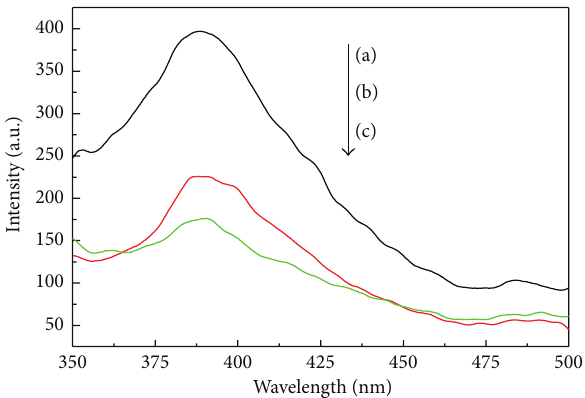
Figure 5: Fluorescence spectra of (a) TiO 2 , (b) ZnO-TiO 2 , and (c) Ni doped ZnO-TiO 2